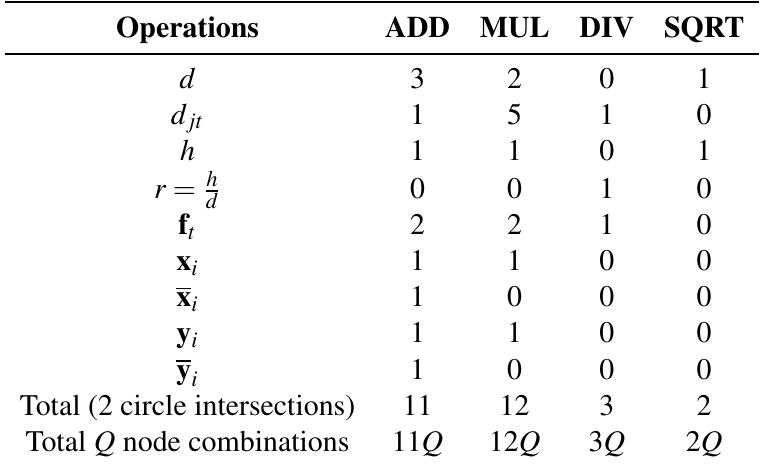
Table 2. Bilateration Cost Operations.